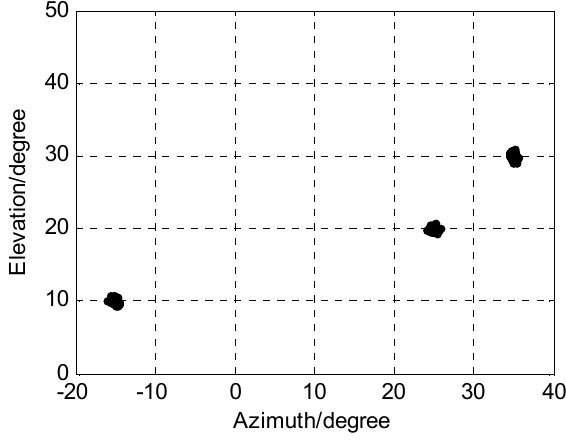
Figure 5. Angle estimation of our algorithm in SNR = 15 dB ( M = 12, J = 100, and K = 3).